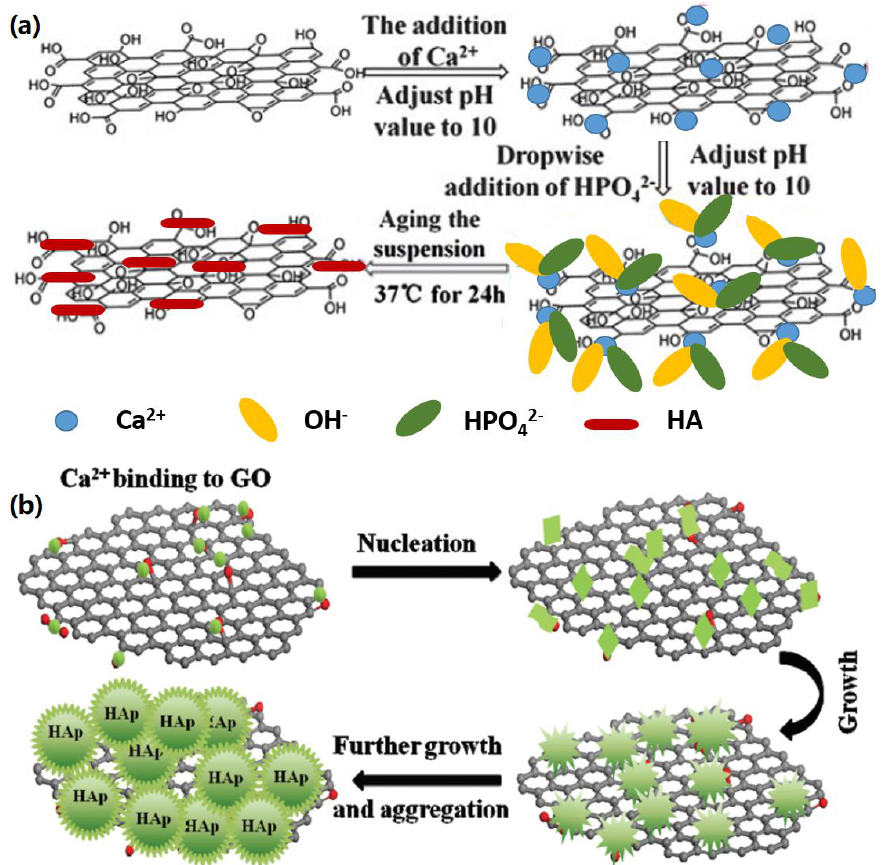
Figure 3. Biomimetic synthesis of HA on pure graphene supports ( a ) HA mineralization on GO in the presence of Ca 2+ and HPO 42 − . Reproduced with the permission from ref. [48]. Copyright 2013 Royal Society of Chemistry. ( b ) HA synthesis on GO in SBF solution. Reprinted with the permission from ref. [51]. Copyright 2014 Royal Society of Chemistry.